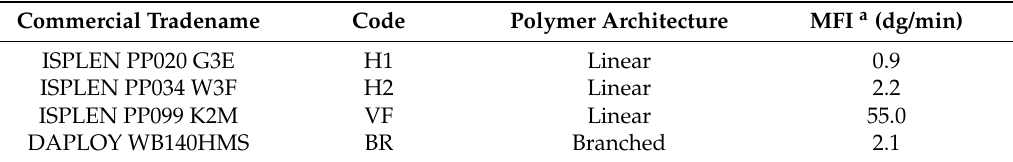
Table 1. Commercial grades of polypropylene